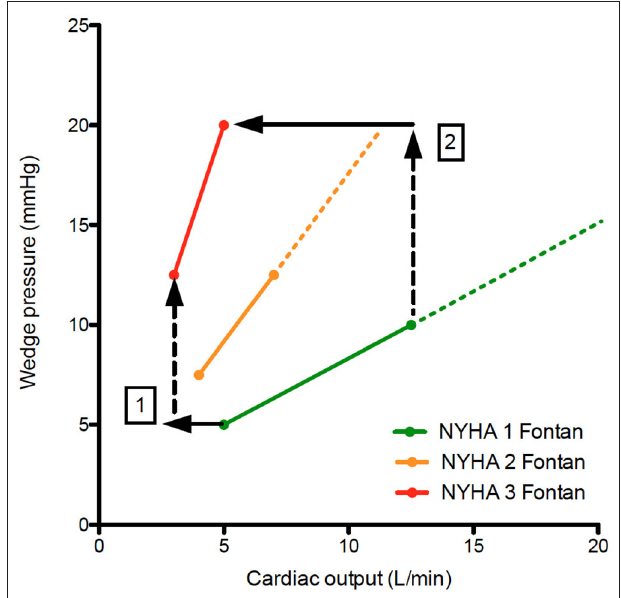
FIGURE 4 | Pressure flow plots indicating the increase in wedge pressure vs. cardiac output during exercise. When comparing NYHA 1 Fontan patients with NYHA 2&3 Fontan patients, note there is a decrease in cardiac output despite increase in wedge pressure (1), which becomes more pronounced during exercise (2). This is counterintuitive in a preload dependent circulation. Diastolic dysfunction (which may be a consequence of preload deprivation) will exacerbate systemic venous hypertension and cardiac output limitation during